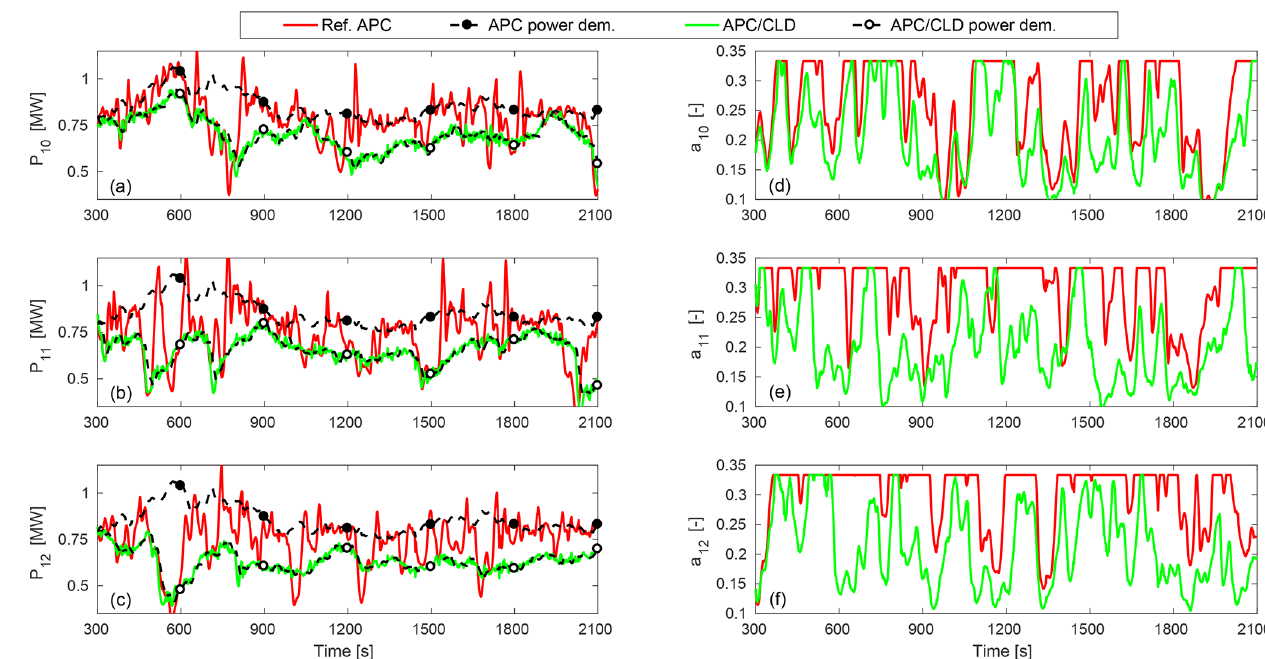
Figure 17. The adjusted power demands (a, b, c) and the corresponding trajectories of the axial induction factors (d, e, f) of the last column (C 4 ) of turbines in the wind farm. Both APC approaches provide almost the same quality of AGC response (see Fig. 12). The power reference = 12 . 3MW, b = 80%, and c = Eq. (23) is parameterized as P base farm